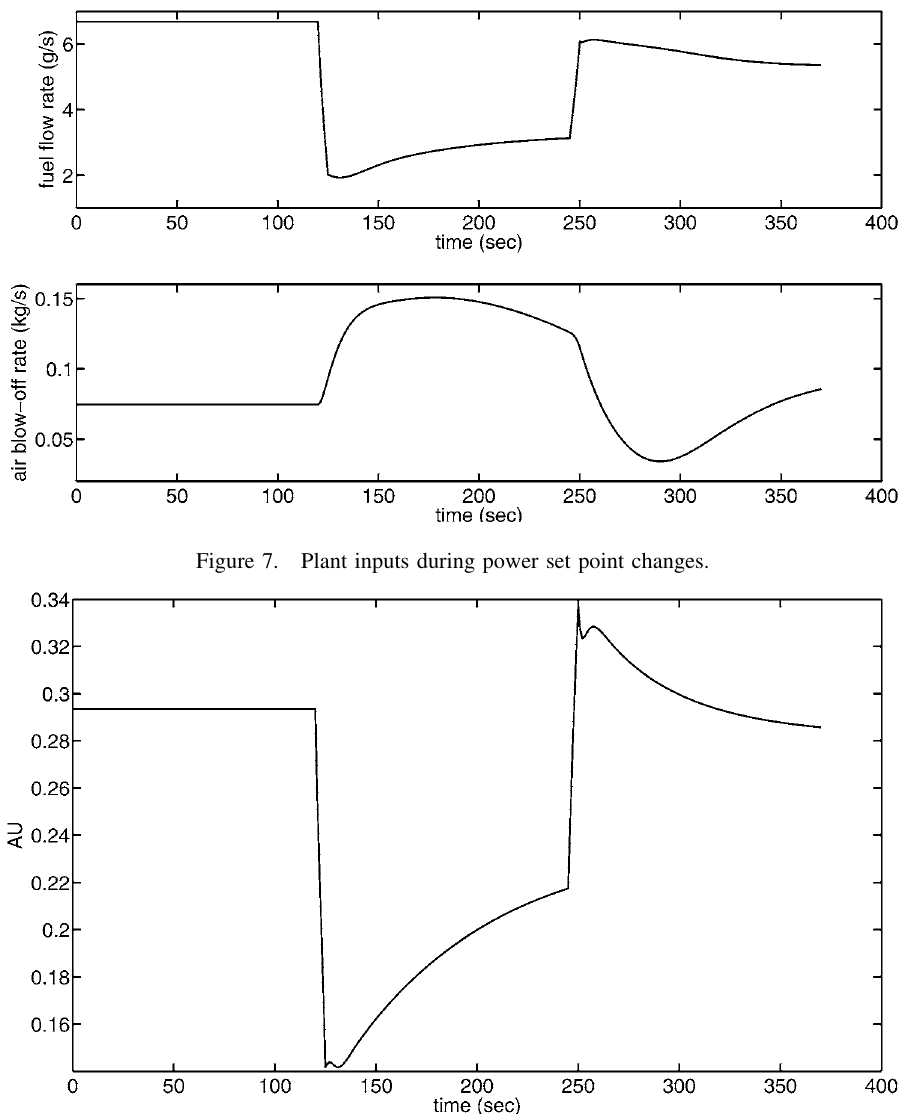
Figure 8. AU profile during power set point